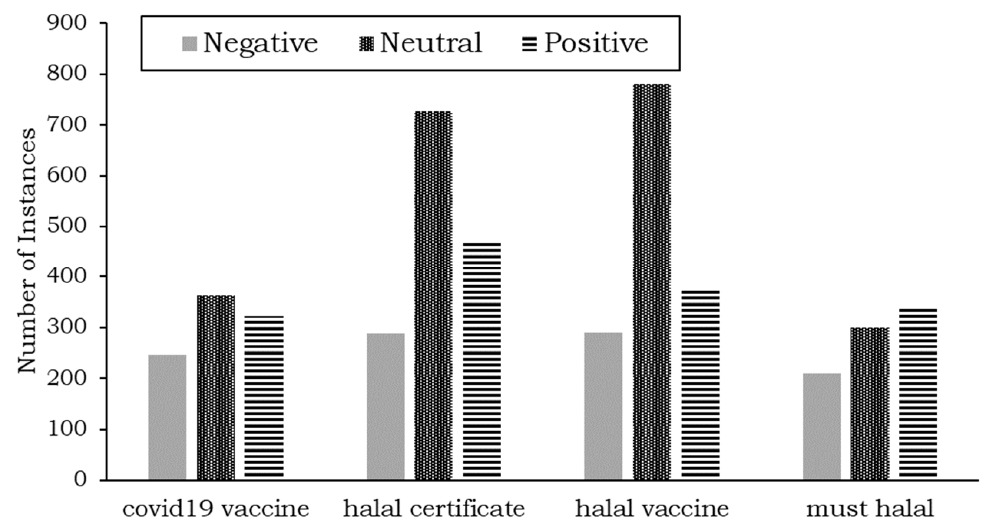
Figure 6. Aspect-based sentiment analysis results for Twitter data.